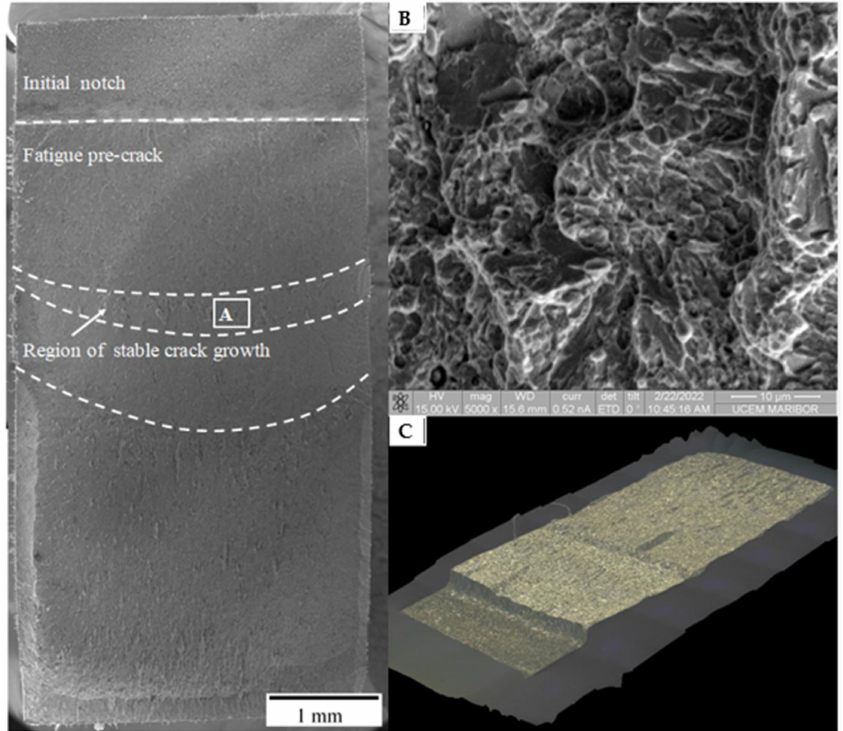
Figure 7. Fracture toughness specimen with fractographic detail: ( A , C ) Region of stable crack growth. ( B ) Isometric image of the fracture